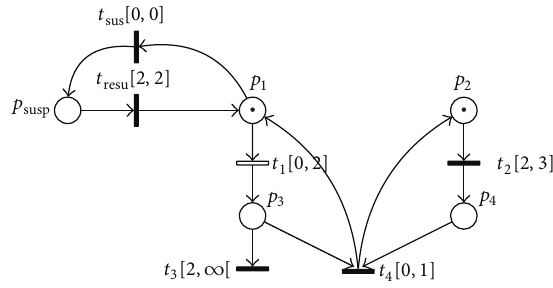
Figure 15: Controlling the example of Figure 1 using stopwatch of [4]. The controller fails.